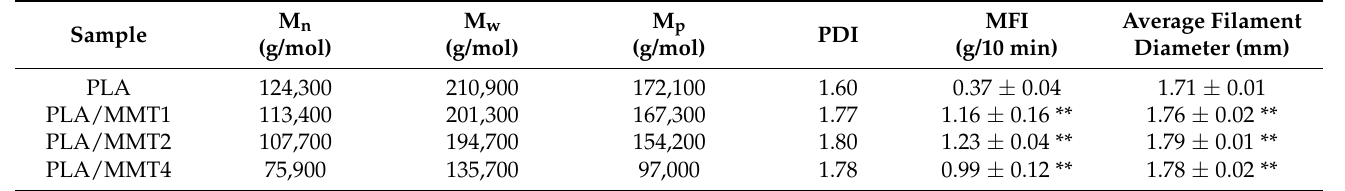
Table 4. Molecular weight, PDI, MFI, and diameter of PLA/MMT